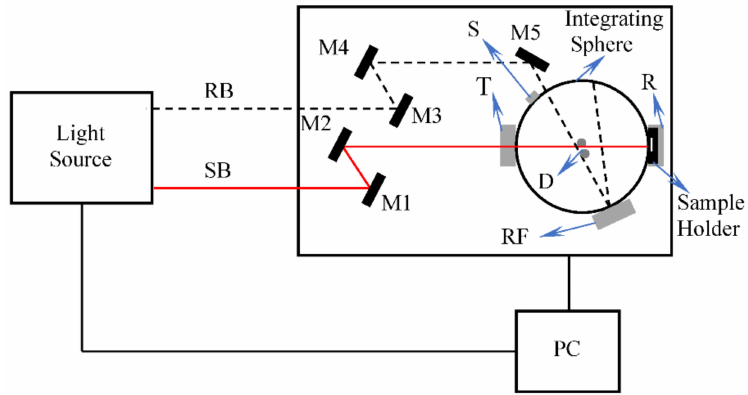
Figure 8. Normal-hemispherical transmission measurement system